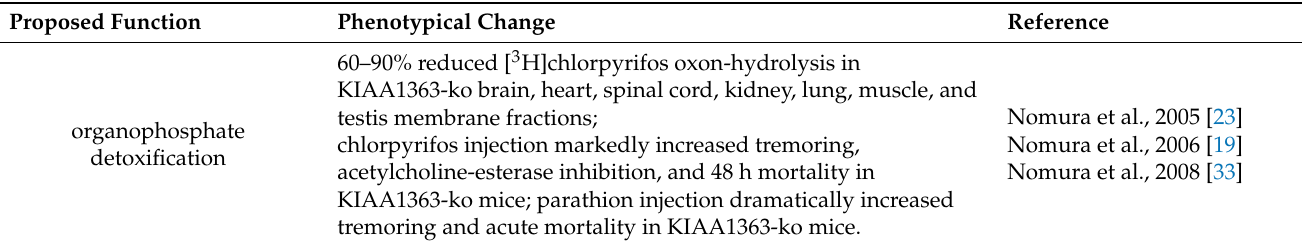
Figure 4. Chlorpyrifos oxon metabolization catalyzed by KIAA1363. Red stars indicate the bond that is hydrolyzed. Table 2. Phenotypical changes in KIAA1363-ko